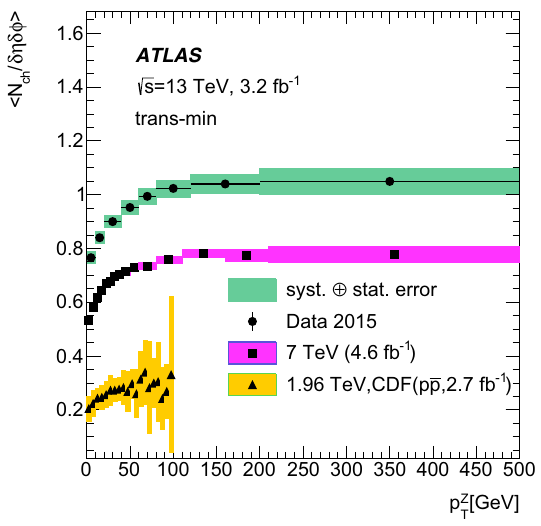
Fig. 12 Comparison of the measured arithmetic mean of mean p T as a function of p Z Powheg + Pythia , Sherpa , and Herwig++ are compared with the data. The ratios shown are predictions over data